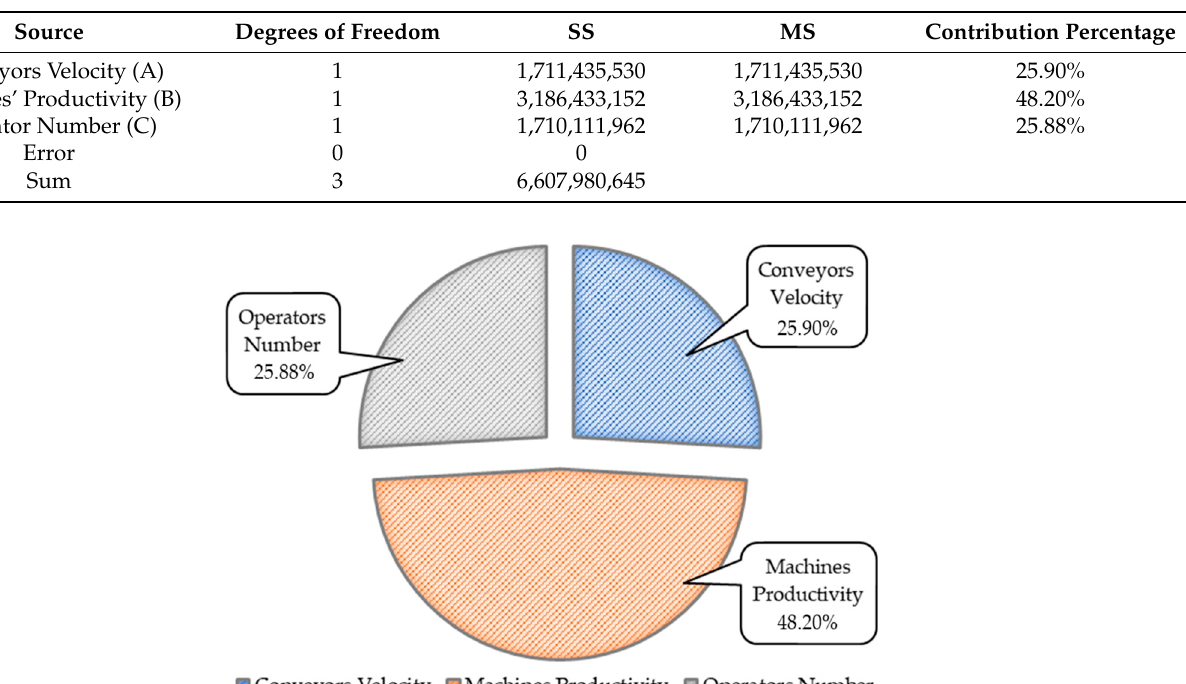
Figure 12. Main E ff ects Plot for SN ratios ( A ) Conveyor Velocity, ( B ) Machine’s Productivity, ( C ) Operator Number.